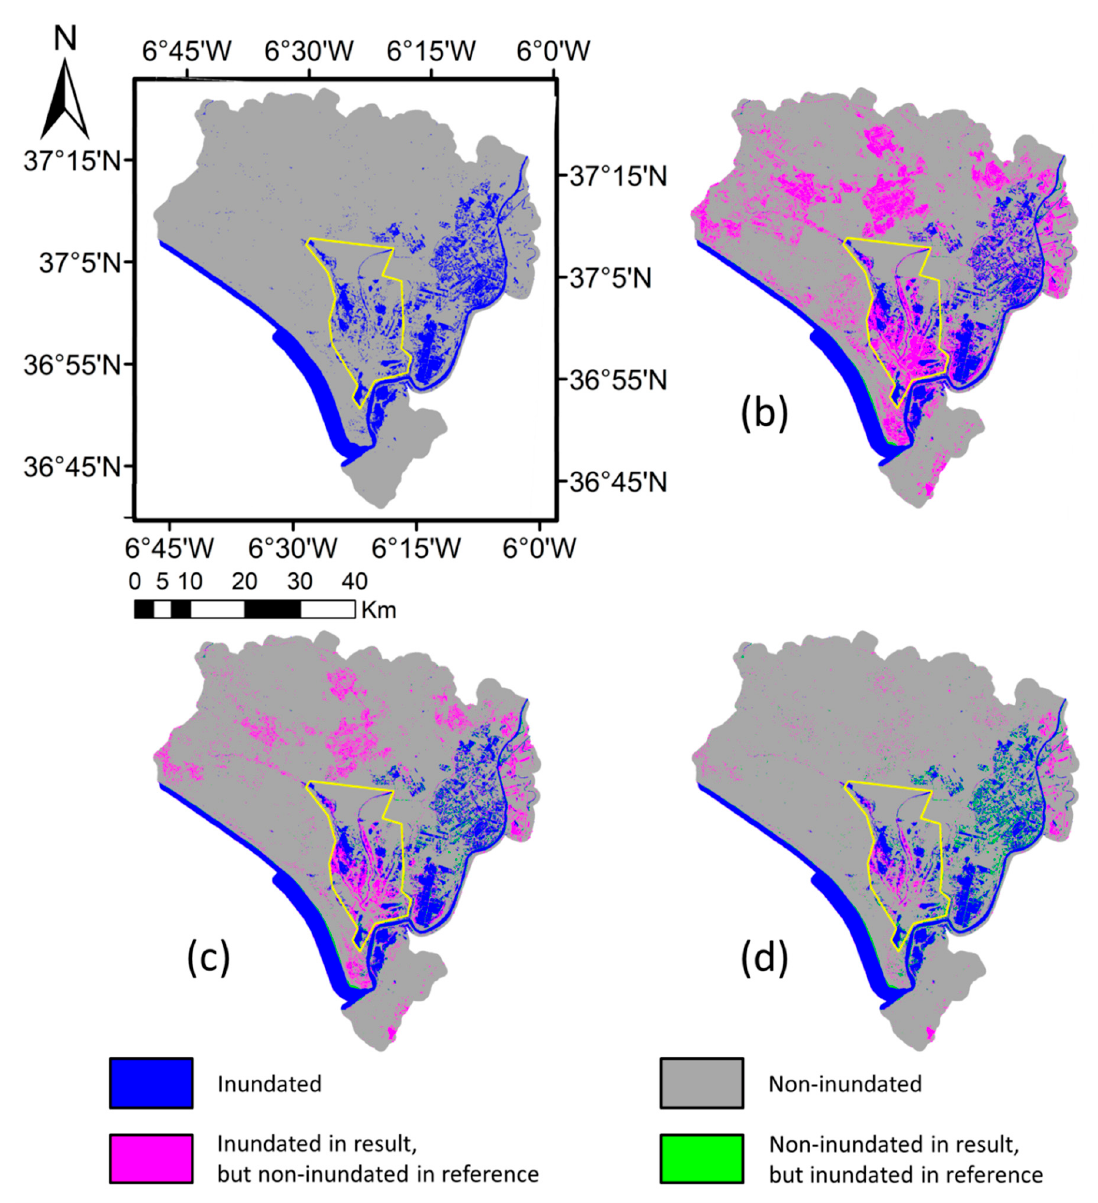
Figure 9. ( a ) Landsat derived inundation map on 27 January, 2018. Inundation map on 27 January, 2018 using ( b ) “Alt3 (OTSU)”, ( c ) “Alt3 (avg)”, and ( d ) “Atl3 (MCET)”. Blue and gray colors correspond to inundated and non-inundated areas, respectively. Green color corresponds to areas classified as inundated in ( a ) but non-inundated in ( b – d ), while the pink color corresponds to areas classified as non-inundated in ( a ) but inundated in ( b – d ). The yellow polygon encloses marshland areas.